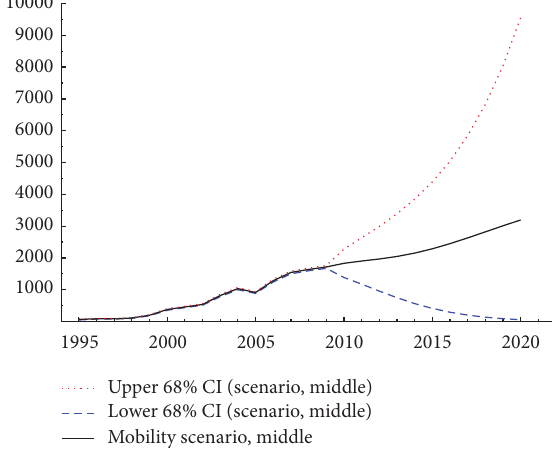
Figure 3: Modelled (1995–2009) and forecasted (2010–2020) abso- lute numbers of Cambodian fatalities, including their 68% confi- dence limits, according to the middle vehicle growth